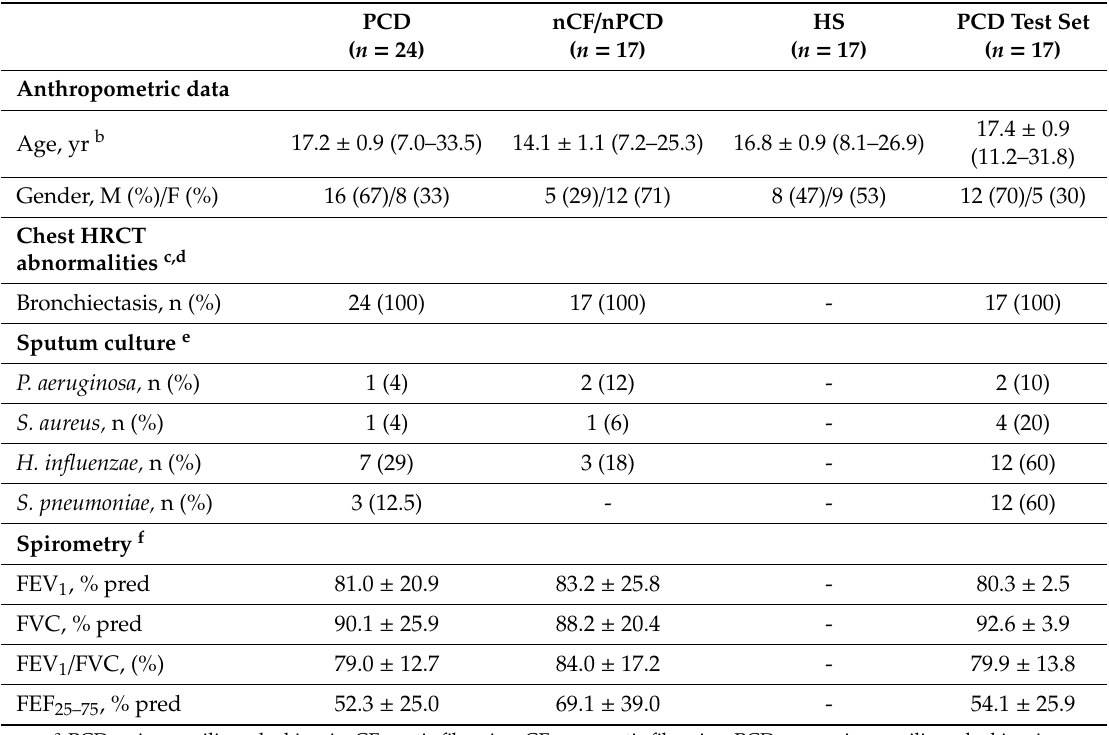
Table 1. Demographic, clinical, and spirometry characteristics of patients enrolled in the study a